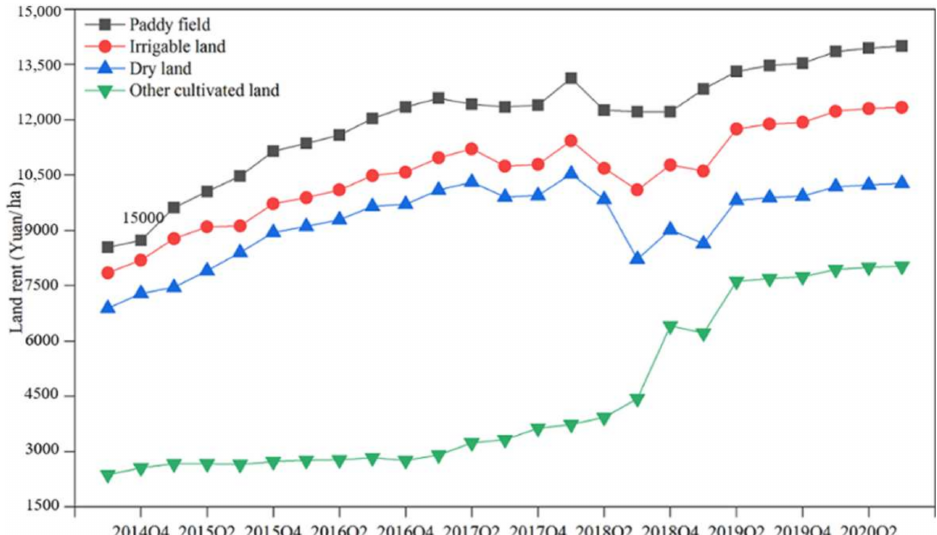
Figure 2. Inter-annual variations in different farmland